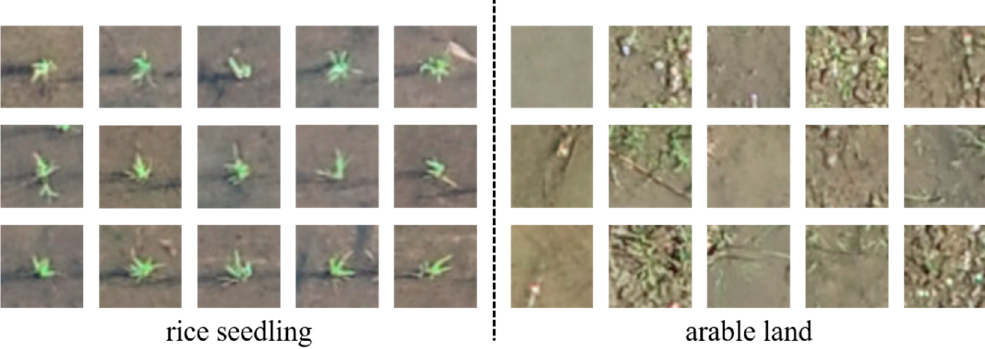
Figure 5. Examples of classes of the rice seedling classification dataset.